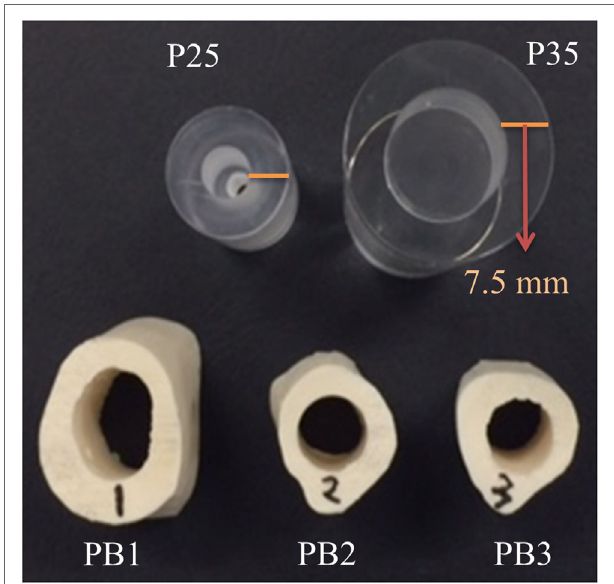
FigUre 2 | Photograph of the Perspex cylinder samples: P25 and P35 with 25 and 35 mm diameters, respectively, and the plastic-bone samples: PB1, PB2, and